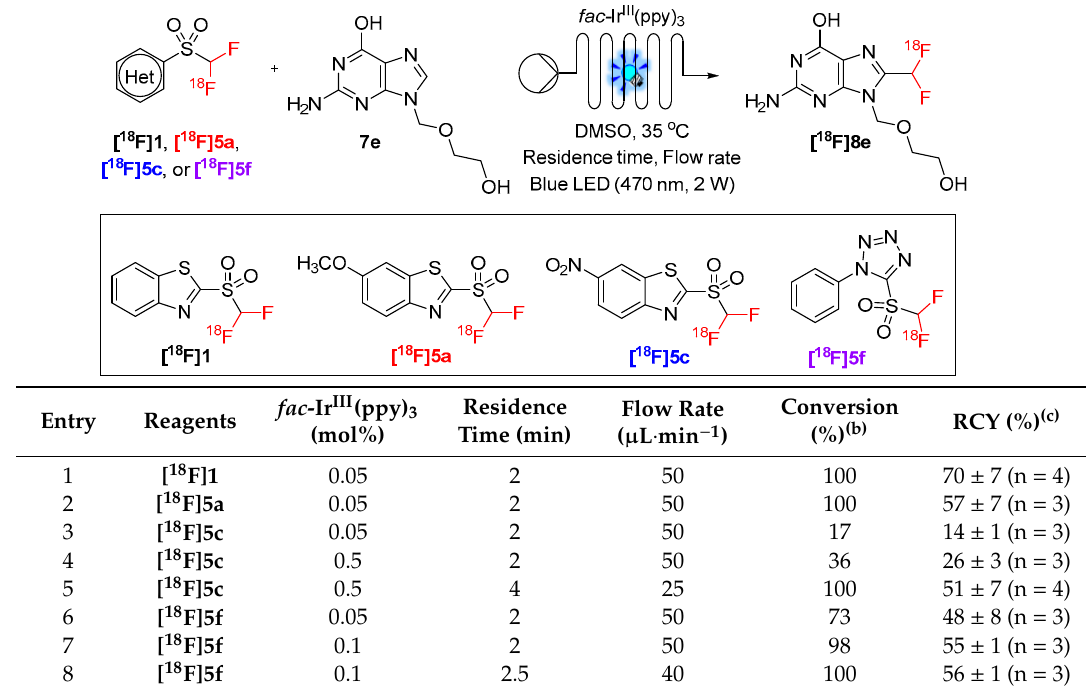
Table 4. Optimization of the conditions for the C–H 18 F-difluoromethylation of acyclovir ( 7e ) with